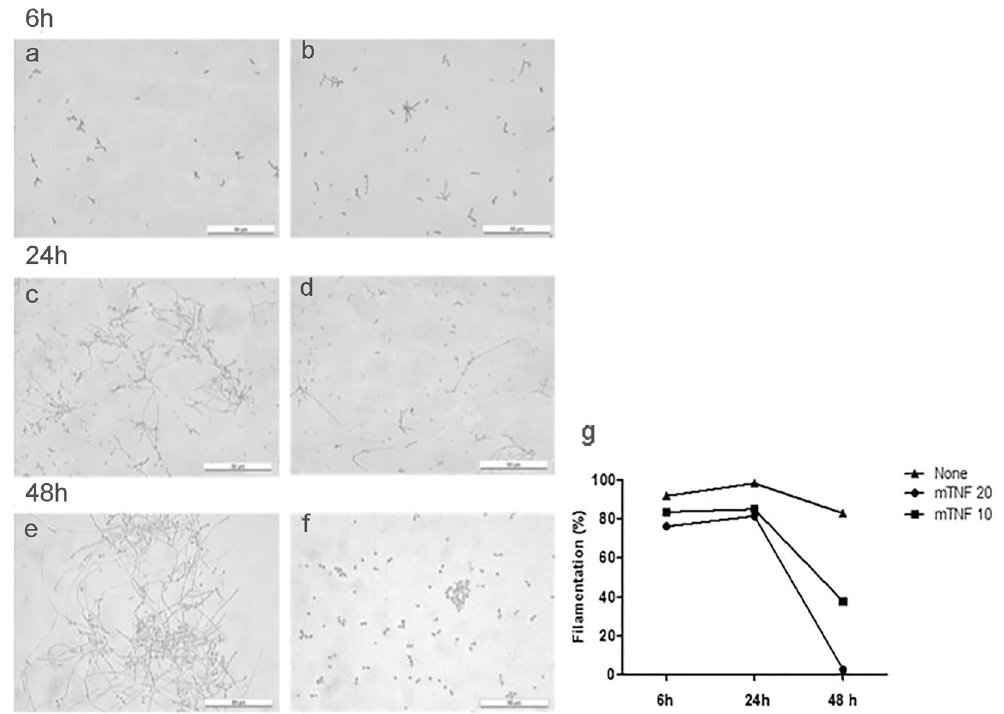
Figure 2. Effect of TNF on the morphology of preformed C. albicans biofilm . Illustrations of lactophenol cotton blue dye stained C. albicans ATCC 10.2.31 growing biofilms treated with TNF (20 ng/mL) ( b , d , f ) or untreated ( a , c , e ) after 6, 24 or 48 h incubation (Original x200); ( g ) C. albicans ATCC 10.2.31 growing biofilms were treated with mTNF (ng/mL) or untreated (none) for 6, 24 or 48 h. Filamentation index represents the percentage of hyphae/yeast measured in 10 high power fields, under inverted optical